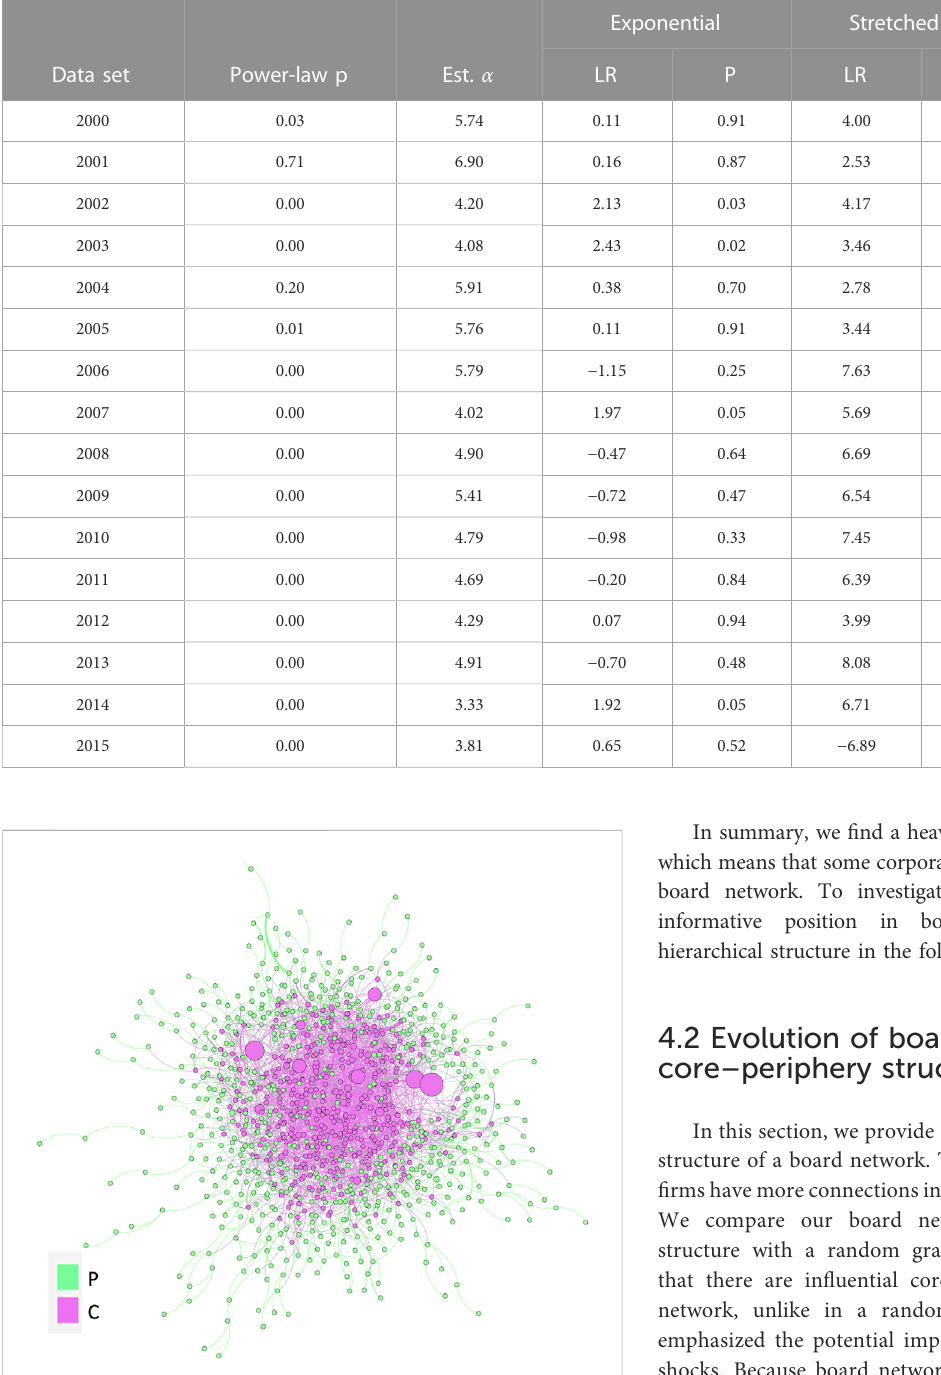
fi nancial industry could form the core with higher degrees than other industries in the board network. We could use this result for risk measurement as exposures to each industry group rather than for valuation for each industry group.